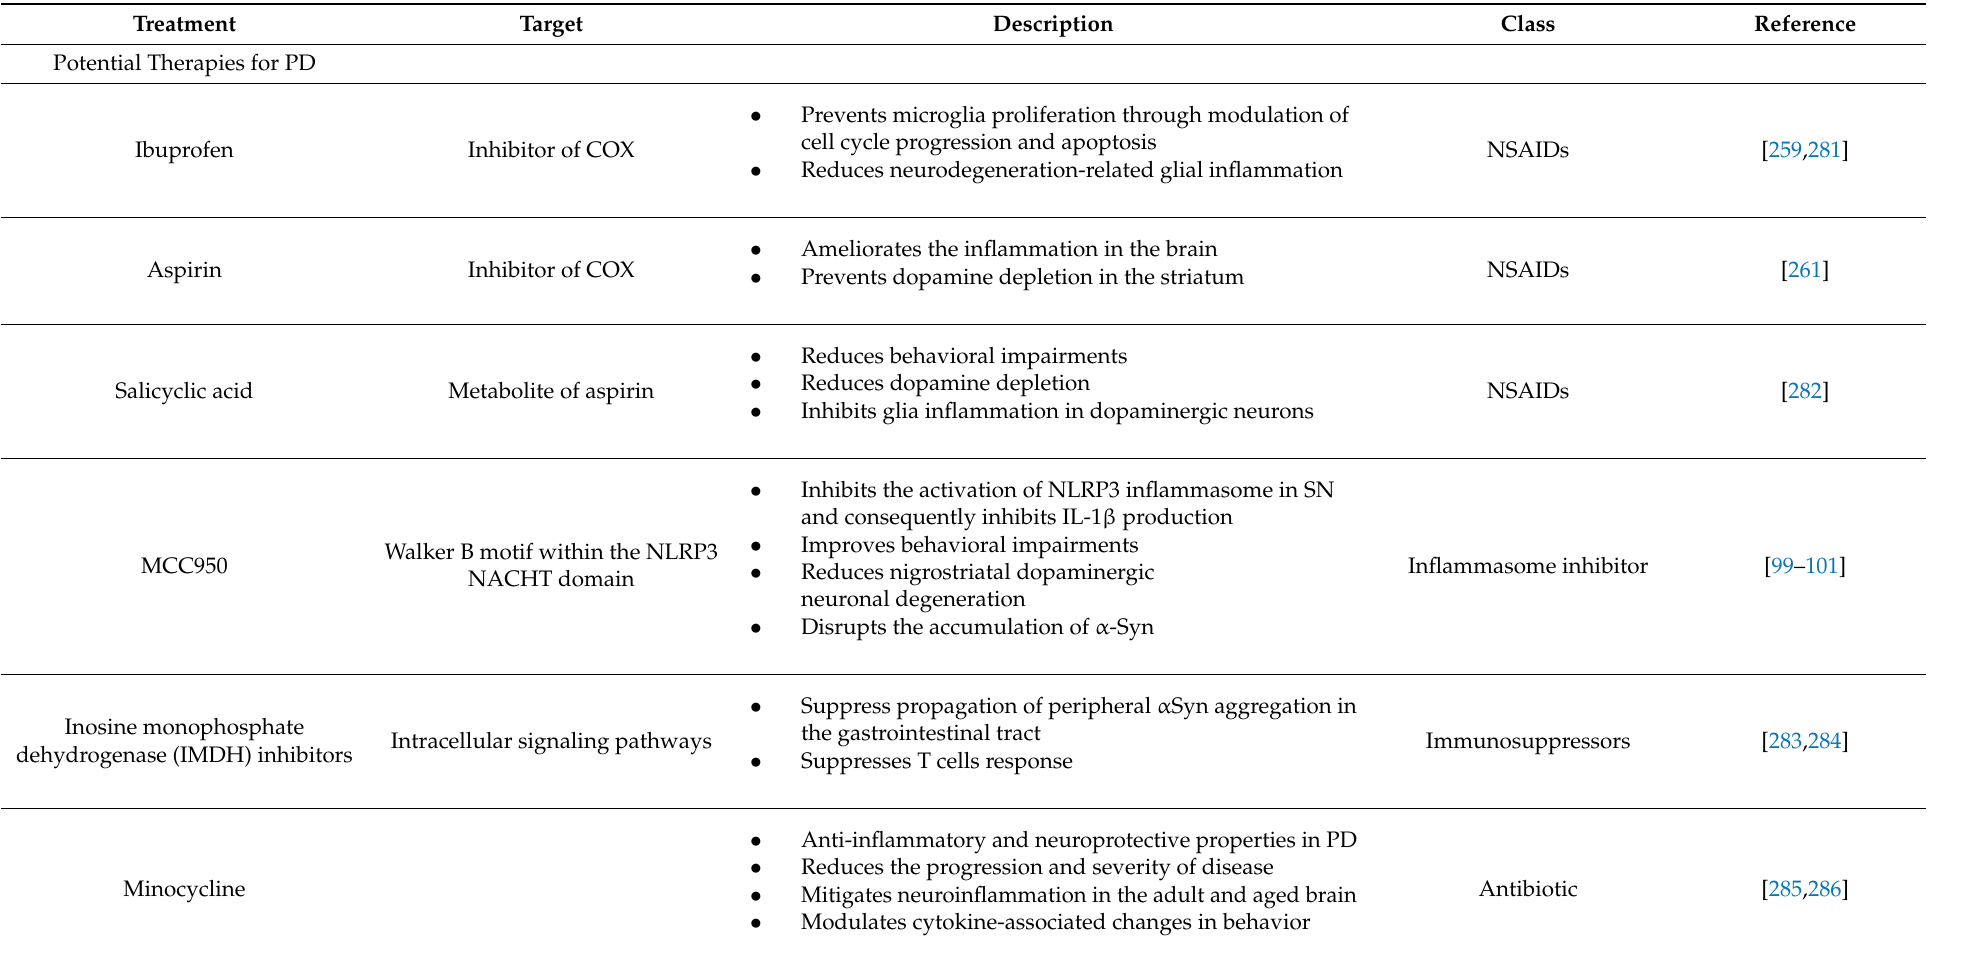
Table 3. Potential pharmacotherapies suitable to pursue to treat Parkinson’s